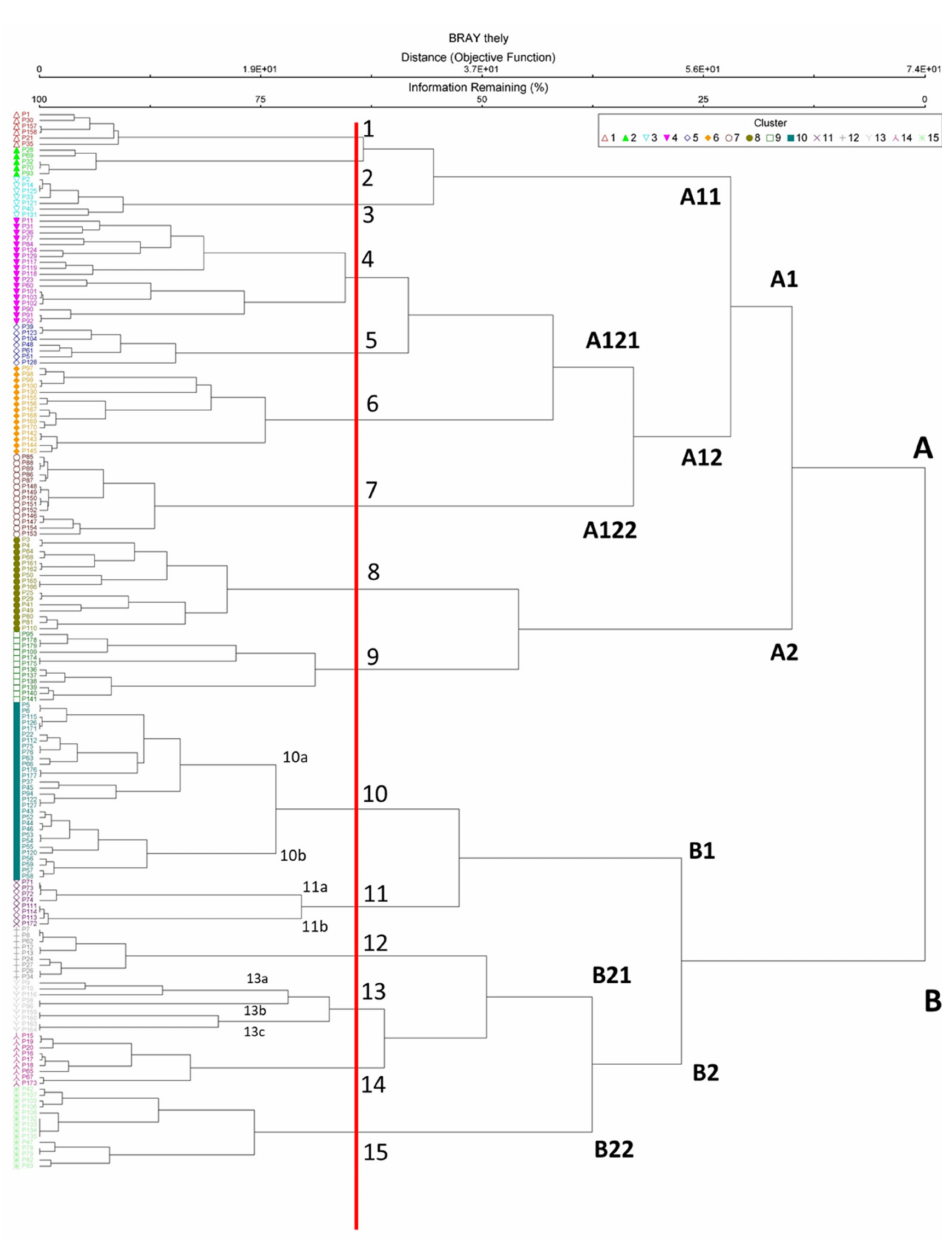
Figure 4. Cluster analysis of 179 unpublished phytosociological relev é s. Plant communities: 1. Spar- ganietum erecti ; 2. Scirpetum lacustris ; 3. Typhetum domingensis ; 4. Galio palustris-Juncetum inflexi ; 5. Eleocharitetum palustris ; 6. Iridetum pseudacori ; 7. Thelypterido palustris-Caricetum paniculatae ; 8. Lythrum portula comm.; 9. Glycerio spicatae-Oenanthetum aquaticae ; 10a. Potametum natantis ; 10b. Utricularietum australis ; 11a. Potamogetono natantis-Polygonetum natantis ; 11b. Potametum pusilli ; 12. Myriophylletum verticillati ; 13a. Lemnetum minoris ; 13b. Potamogetono-Ceratophylletum submersi ; 13c. Ranunculetum omiophylli ; 14. Ranunculetum aquatilis ; 15. Wolffietum arrhizae